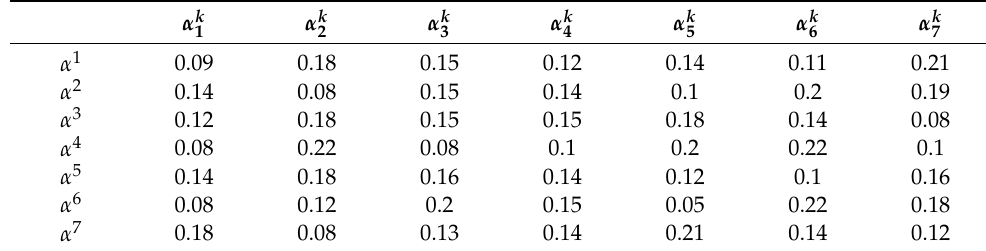
Table 5. The relative weights of objective functions corresponding to the given